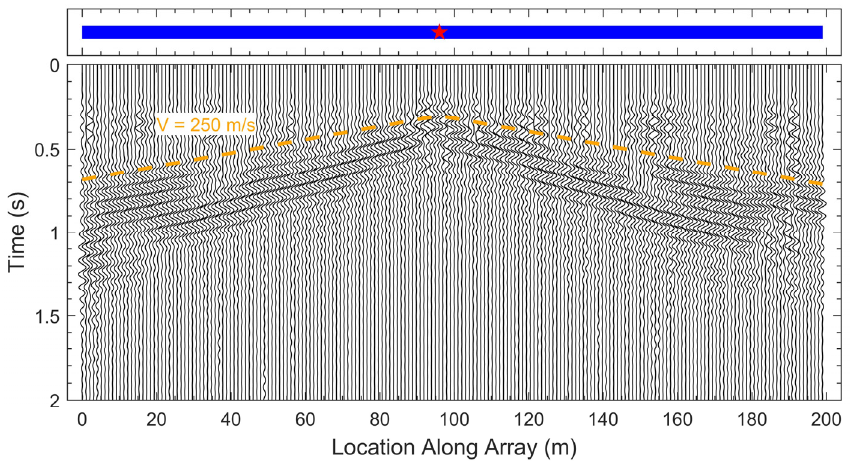
Figure 2. Observed DAS waveforms for Shot 16 at 96 m. The shot location and DAS array are shown above the waveforms as a red star and blue line, respectively. A reference line for a moveout velocity of 250 m/s is also shown.